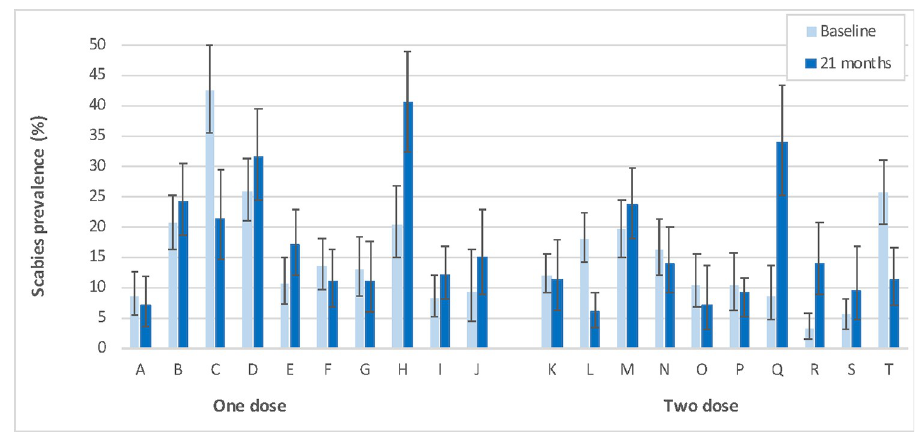
Fig 4. Scabies prevalence before mass drug administration and at 21 months by villages (error bars indicate 95% confidence interval). https://doi.org/10.1371/journal.pntd.0011207.g004 those who had not. In Arm 2 the prevalence was 10 � 8% (95% CI 9 � 0–12 � 8) in participants who had been present at baseline and 17 � 8% (95% CI 14 � 9–21 � 1) in those who had not. The change